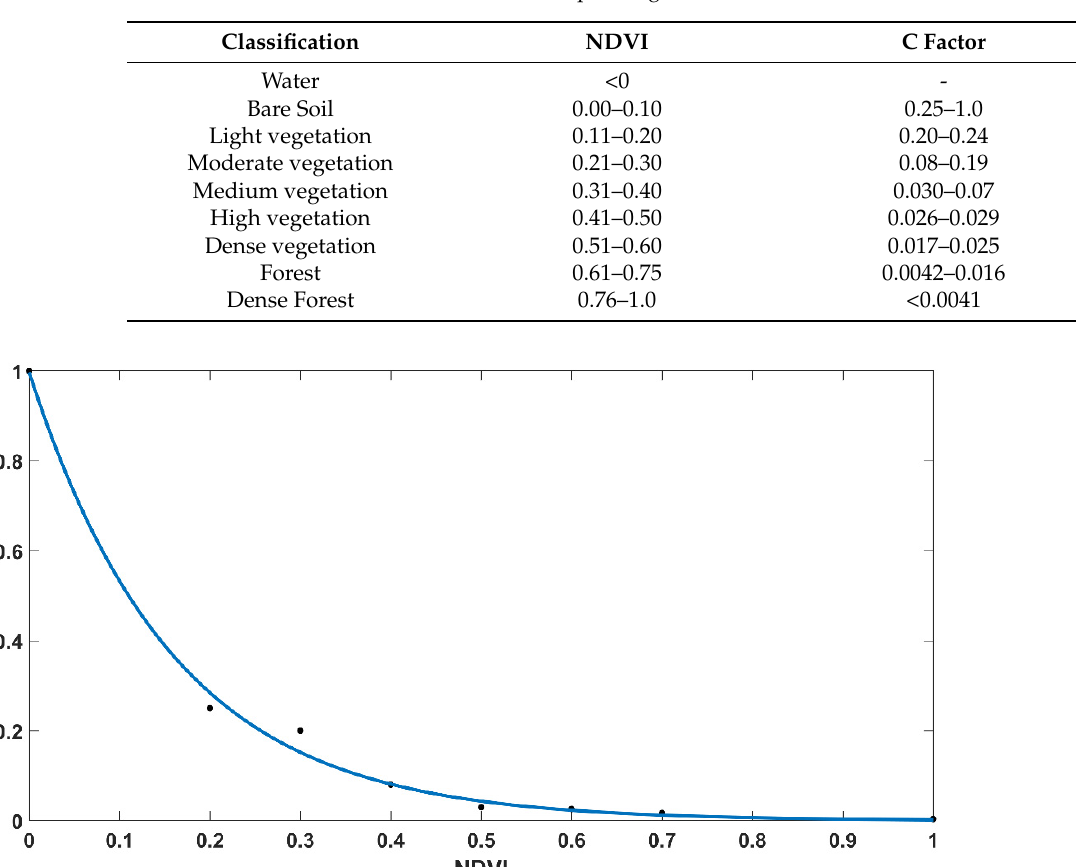
Table 2. Land cover classifications with corresponding NDVI and C factor values, used in this study.